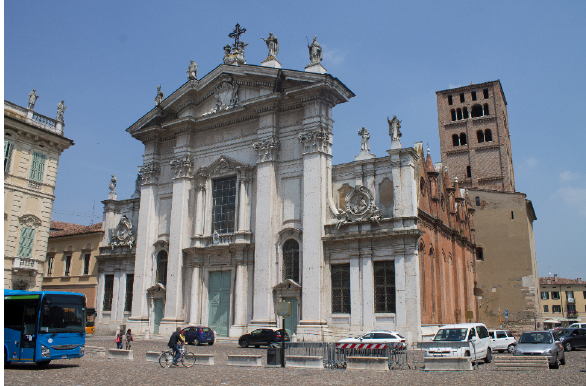
Figure 1. Mantua Cathedral Fac¸ade, photo by